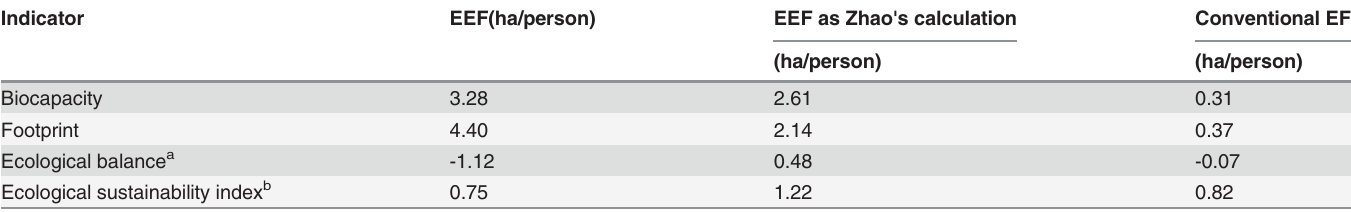
Table 3. Comparison of fi nal 2009 indicators obtained from the different ecological footprint approaches.